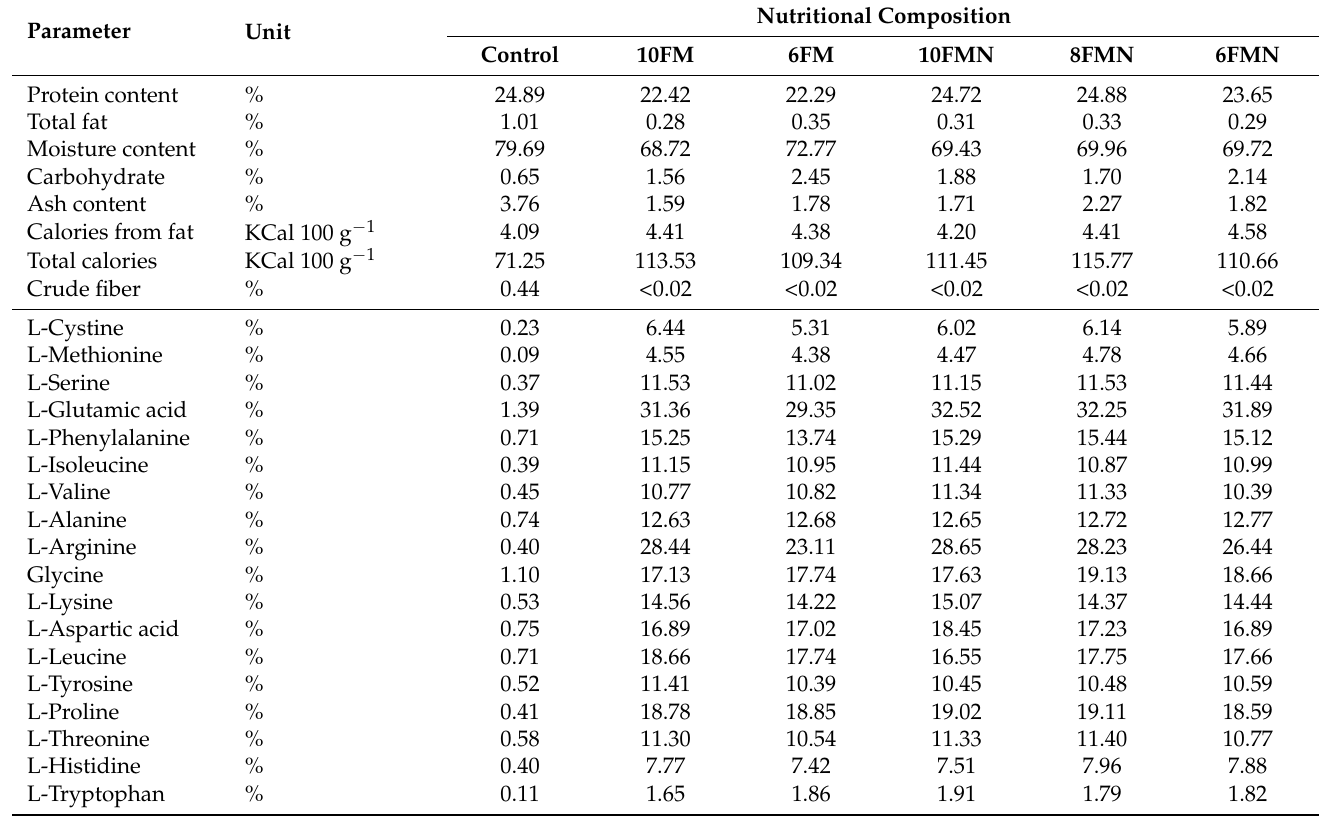
Table 4. Proximate composition (%, as is ), calories from fat and total calories of feed (KCal 100 g − 1 ), and amino acid profile (%, as is ) of Pacific white shrimp (PWS) whole body at the end of the 110-day growth